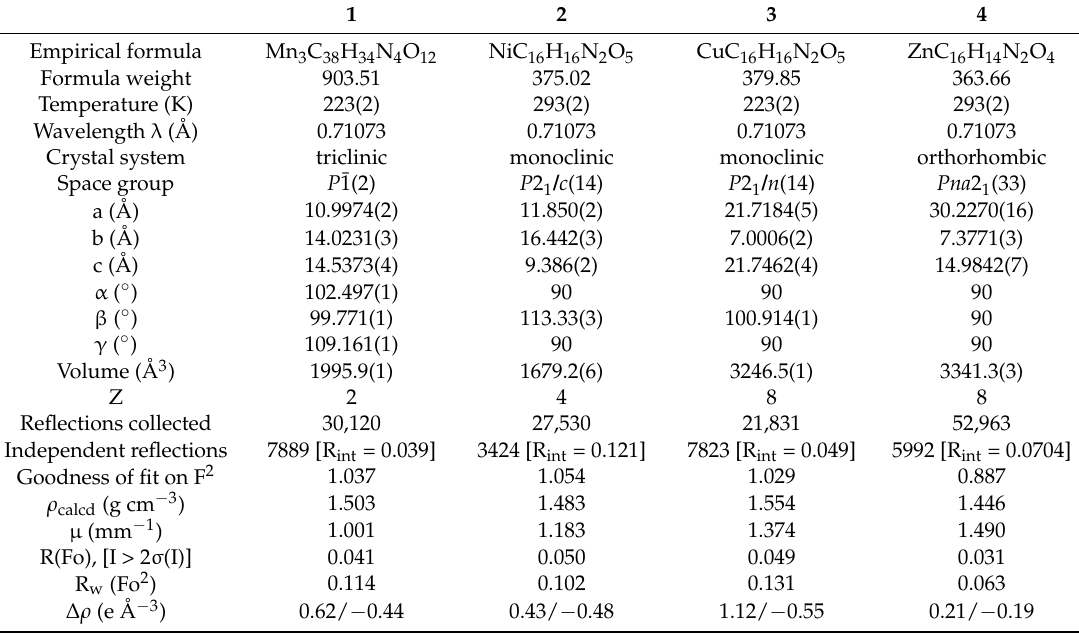
Table 1. Crystal data and structure refinement for complexes ( 1 )–( 4